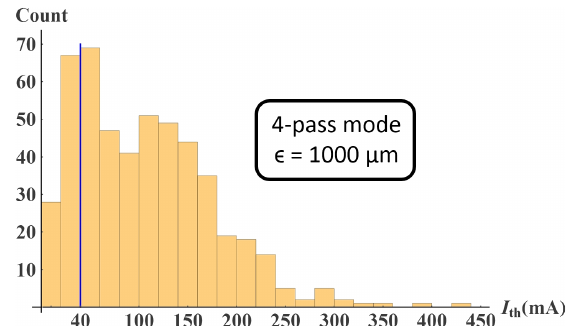
FIG. 7. 500 BBU simulation results of I with cavity shape errors within ϵ ¼ 1000 μ m.